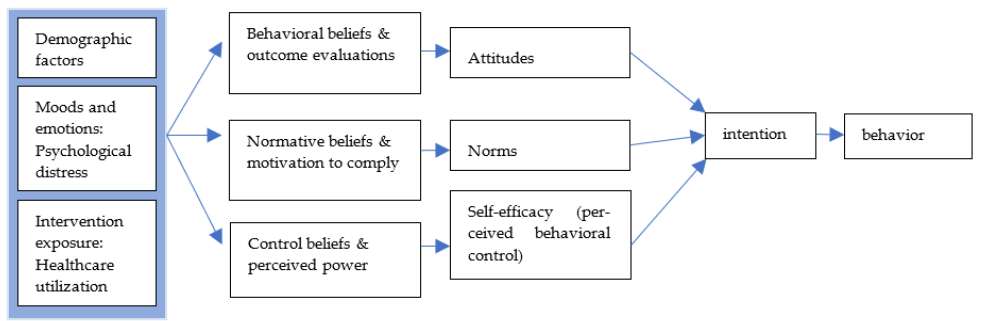
Figure 1. Integrated Model of Behavioral Prediction.